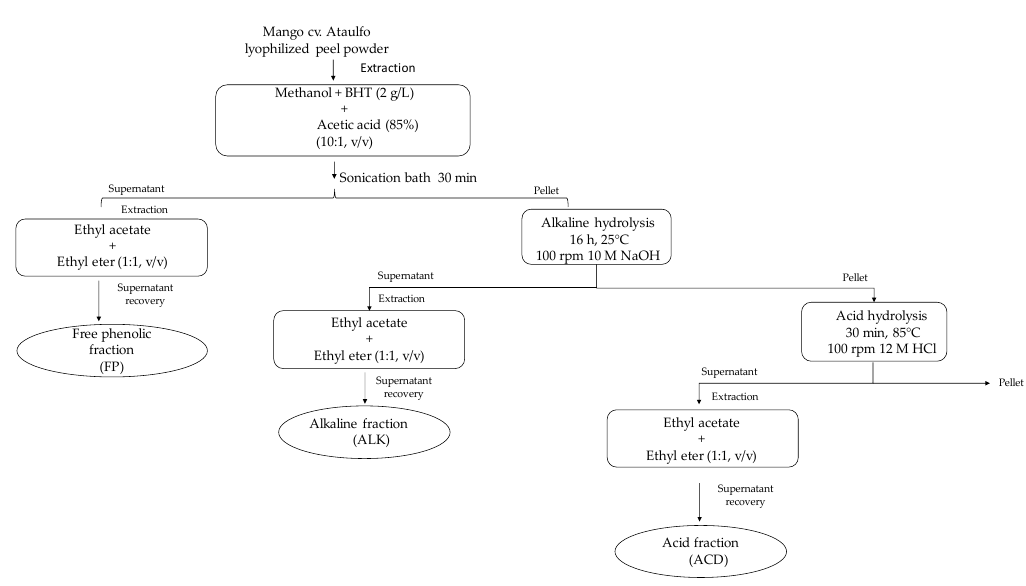
Figure 5. Schematic description of the extraction procedure to obtain free phenolic (FP), alkaline (ALK), and acid (ACD) fractions from mango cv. Ataulfo peel.